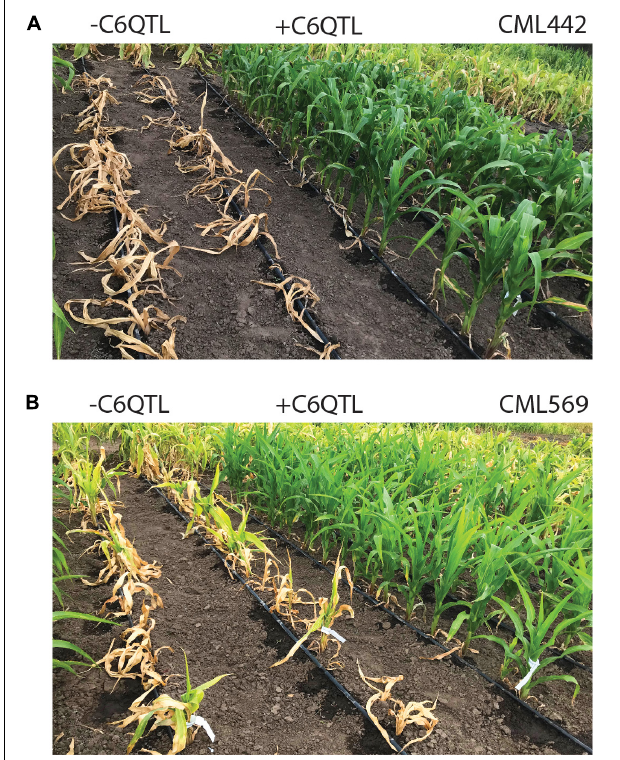
FIGURE 2 | A large-effect QTL provides strong protection against maize lethal necrosis (MLN). Inbred line CML442 (A) and CML569 (B) after inoculation with the MLN viruses without (left) or with (right) the C6QTL from the inbred donor line KS23-6 after four backcrosses to the recurrent parent. The lines were screened for MLN in Naivasha, Kenya. Picture credit: Michael